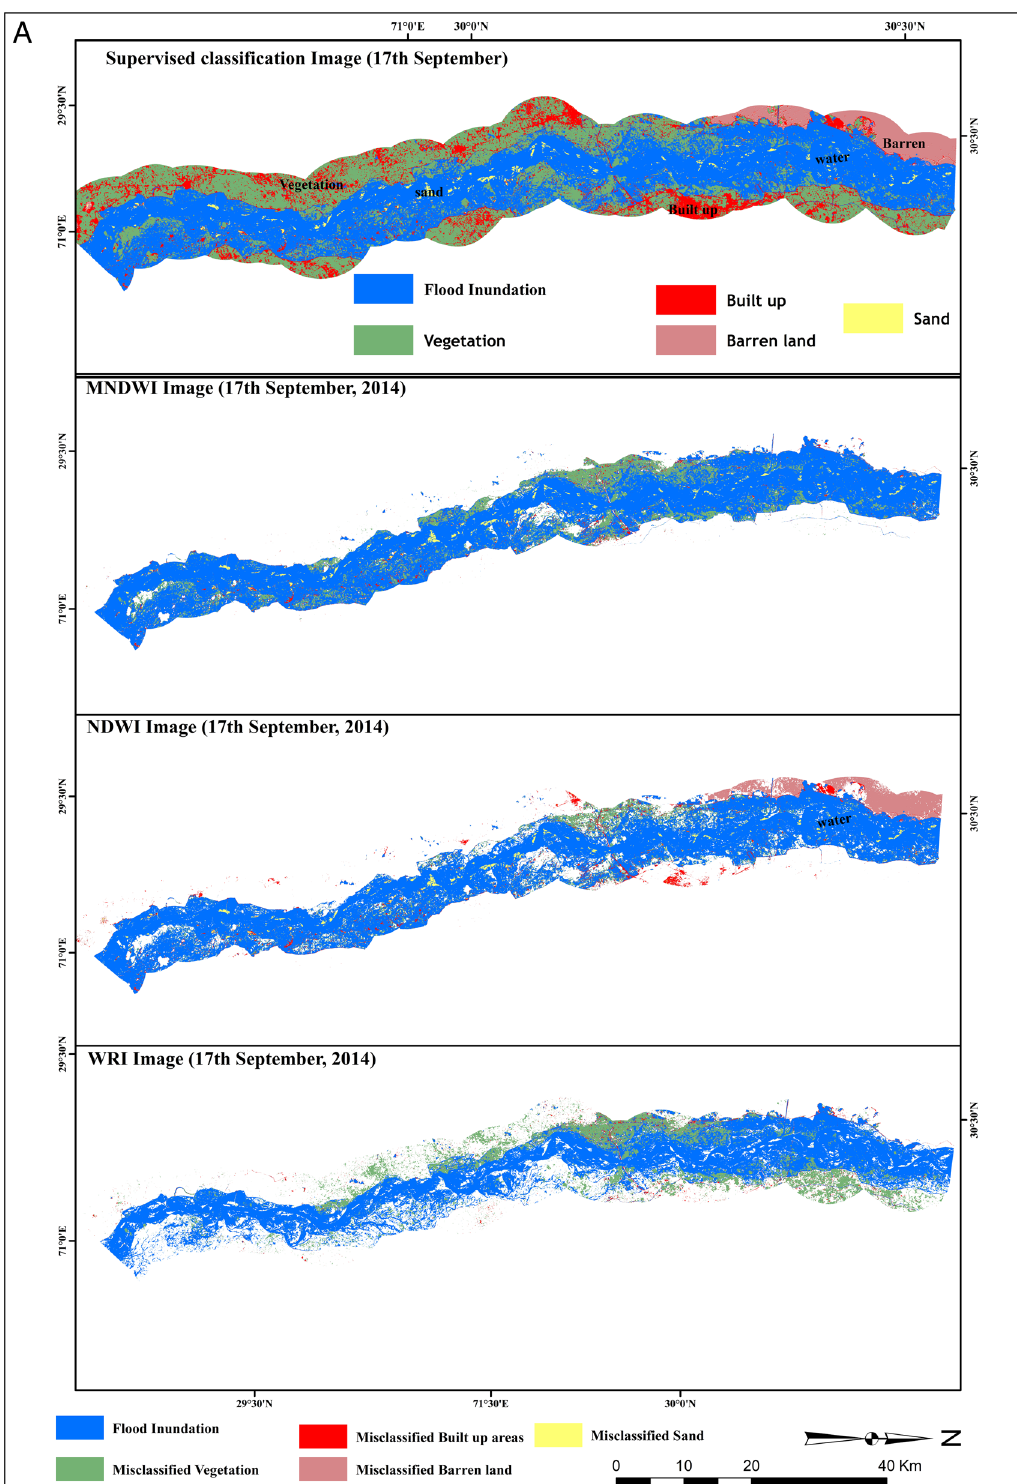
Fig. 10 A . A comparison of Flood inundation using ML Classification, MNDWI, NDWI and WRI indices. B . A comparison of Flood inundation using GE, MNDWI, NDWI, and WRI